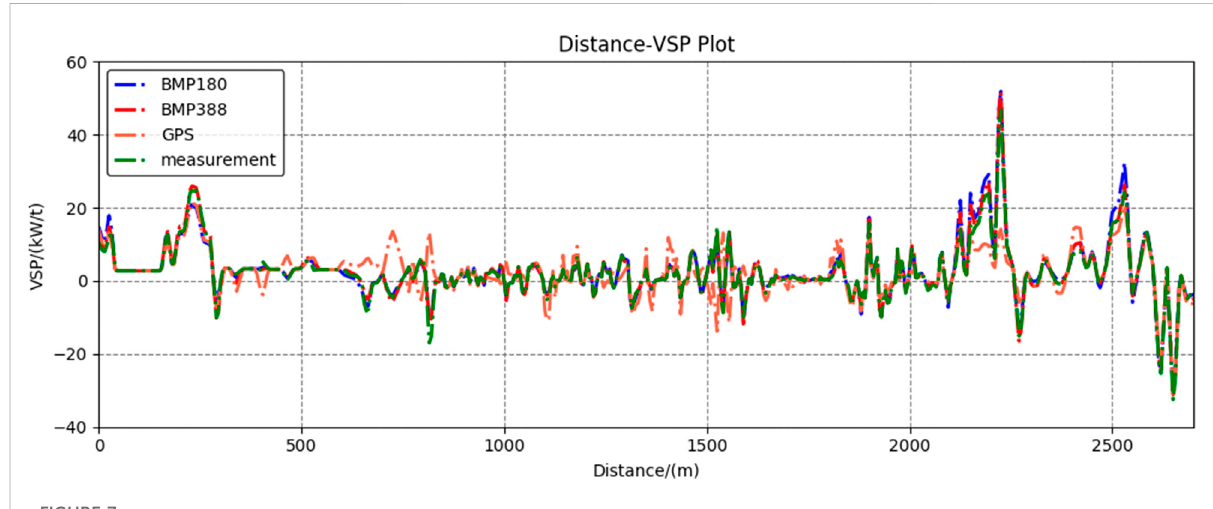
FIGURE 7 VSP variations of validation section based on different